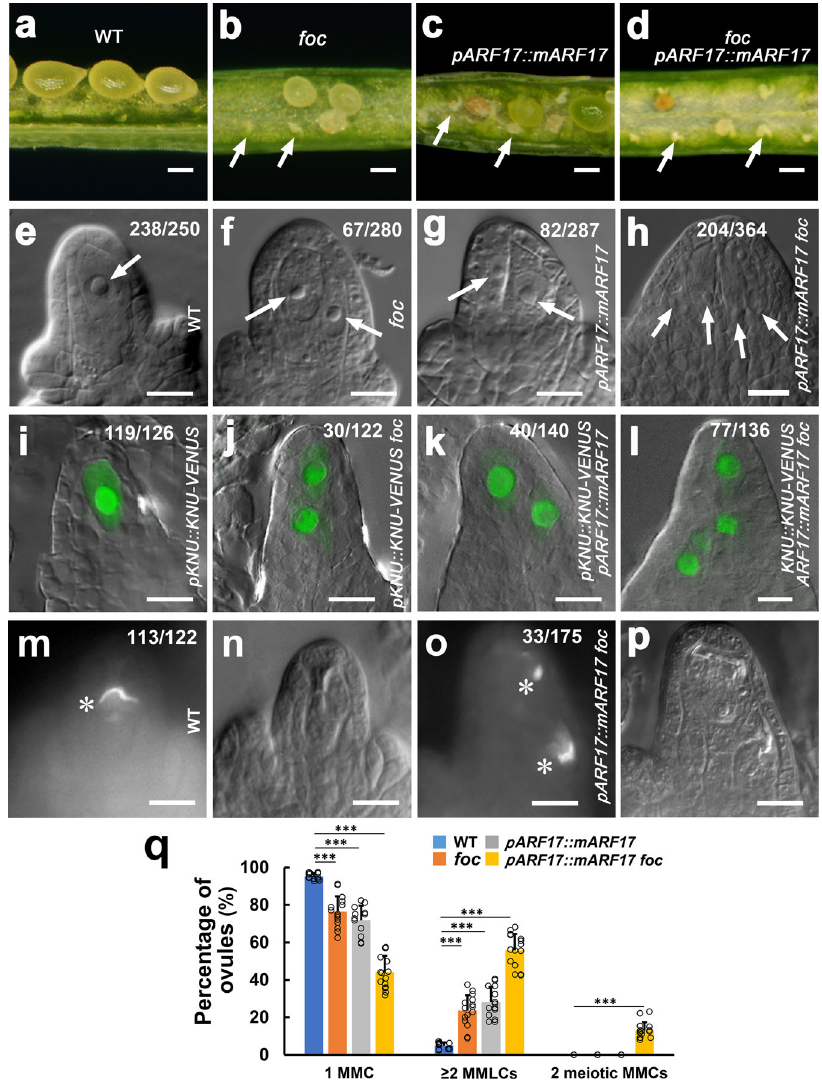
Fig. 1 | miR160 and its target ARF17 control MMC formation. a – d Development of abnormal ovules. Developing seeds in the silique from the L er wild-type (WT) plant ( a ), and aborted ovules in siliques of foc ( b ), ARF17::mARF17 ( c ), and ARF17::mARF17 foc ( d ) plants. Arrows indicate aborted ovules. e – p Formation of supernumerary MMCLs and MMCs. e – h Differential interference contrast (DIC) imagesof ovulesshowingMMCLs(arrows). i – l MergedconfocalandDICimagesof ovules expressing pKNU::KNU-VENUS marking the MMC fate. m – p Callose deposi- tion indicating MMC undergoing meiosis. e , i A single MMC in the wild-type (WT) ovule. f , j Two MMCLs in the foc ovule. g , k Two MMCLs in the pARF17::mARF17